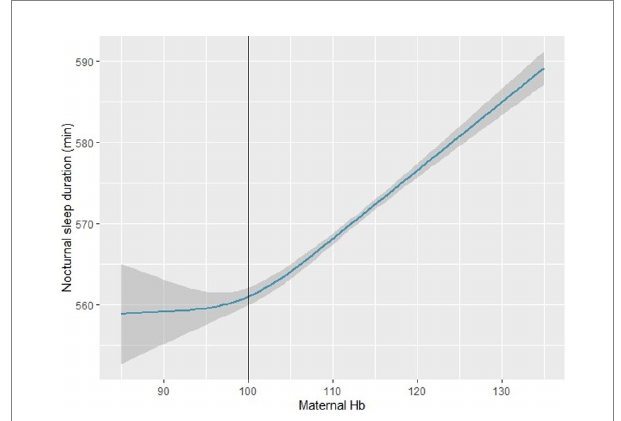
FIGURE 1 Association between maternal hemoglobin concentration and infant nocturnal sleep duration in the restricted cubic spline model ( n = 2,410). The restricted cubic spline model adjusted for maternal age at delivery, education levels, family income, pre-pregnancy BMI, SBP, DBP, daily iron supplementation, maternal diet (fruits, dessert, vegetables, bean products), infant gender, preterm birth, SGA, LGA, breastfeeding. SGA: small for gestational age; LGA: large for gestational age. BMI: Body mass index; SBP: systolic blood pressure; DBP: diastolic blood pressure; SGA: small for gestational age;